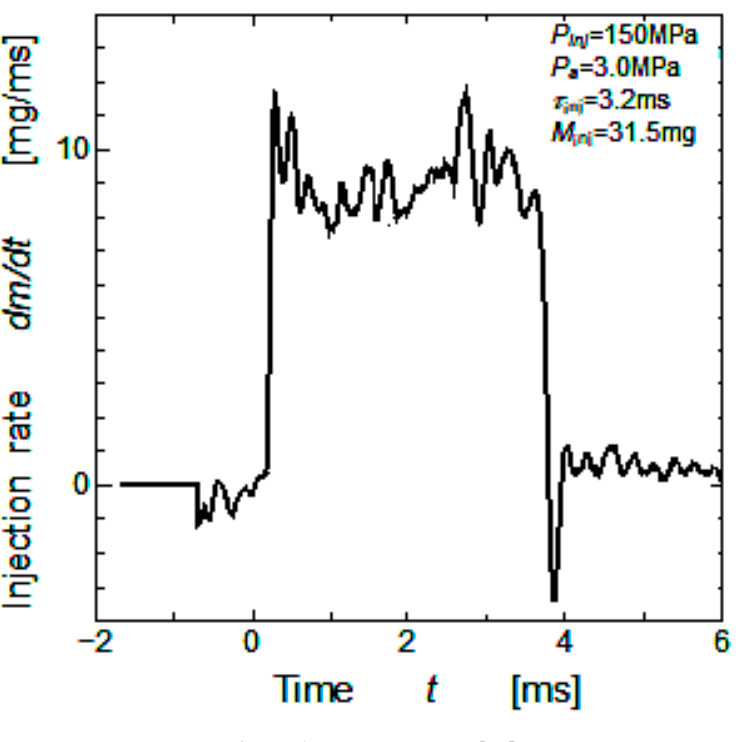
Figure 7. Injection rate of tested injection system [16].